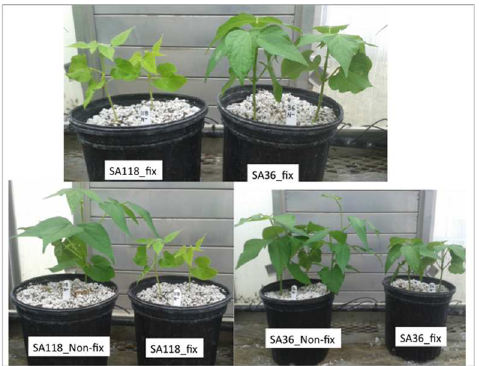
Fig 1. Growth characteristic of SA36 and SA118under fixing and non-fixing condition grown in the